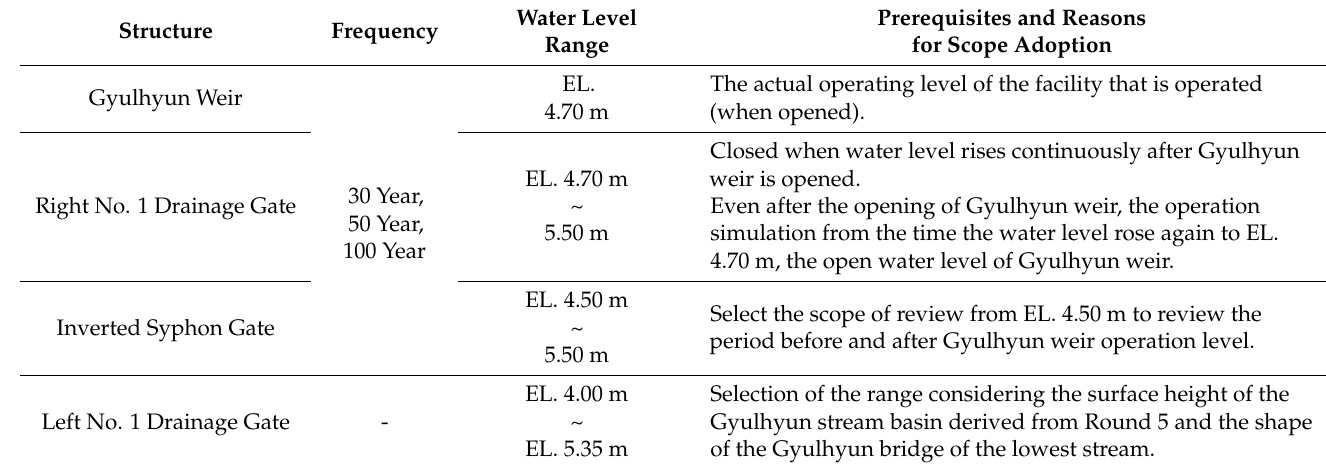
Table 5. Operation Plan Setting